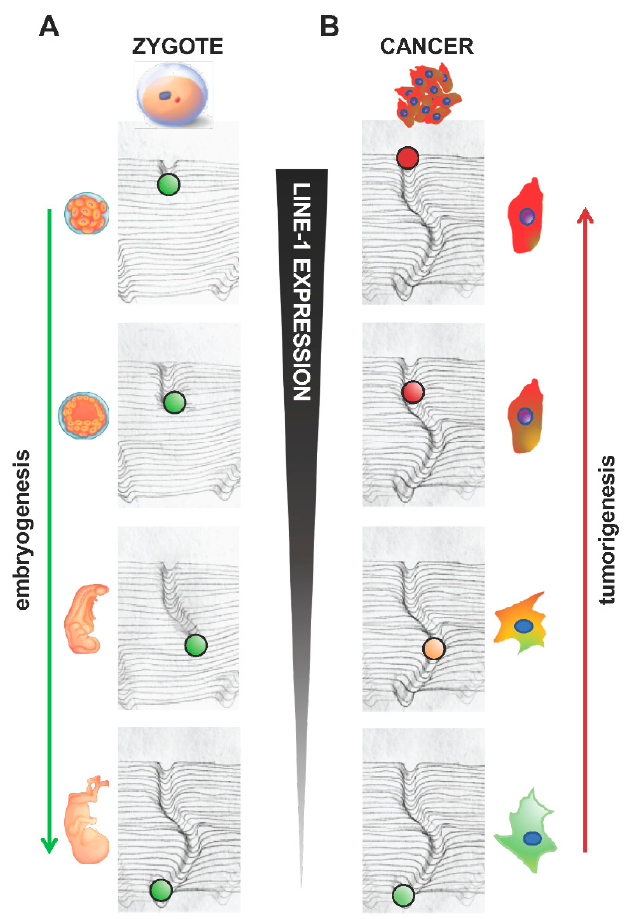
Figure 3. Reactivation of embryonic genetic circuits in differentiated cells triggers cancer onset: a model. Schematic illustration, inspired by Waddington’s model, representing the following: ( A ) The process of the canalization of the epigenetic landscape during embryogenesis; the canal formed by the green ball rolling from the top of the hill represents new genomic circuit(s) shaping the epigenetic landscape. ( B ) Aberrant reactivation of embryonic gene expression in differentiated cells (green cell, bottom right panel) triggers cell de-differentiation and the formation of heterogeneous cell populations with different degrees of malignancy (shades from yellow to red). The extent of malignancy would depend on how far back the cell retraced the canalized circuit, reflected by varying extents of de-differentiation. Correspondingly, LINE-1 expression is high in early embryos and in de-differentiated cells, and very low in differentiated cells and tissues.